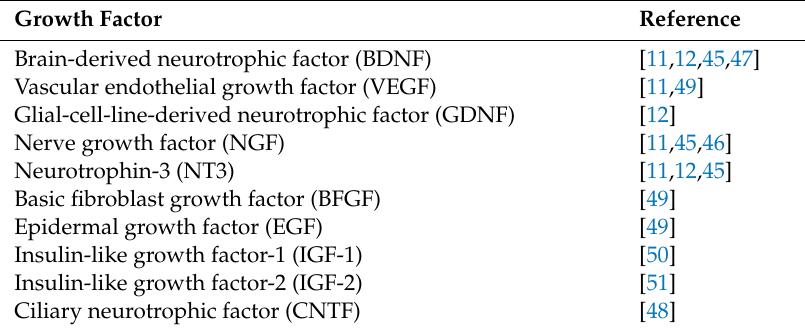
Table 4. Main growth factors detected in the hNSC-derived secretome. The exploitation of NSCs’ paracrine properties relies on the presence of needed factors in their